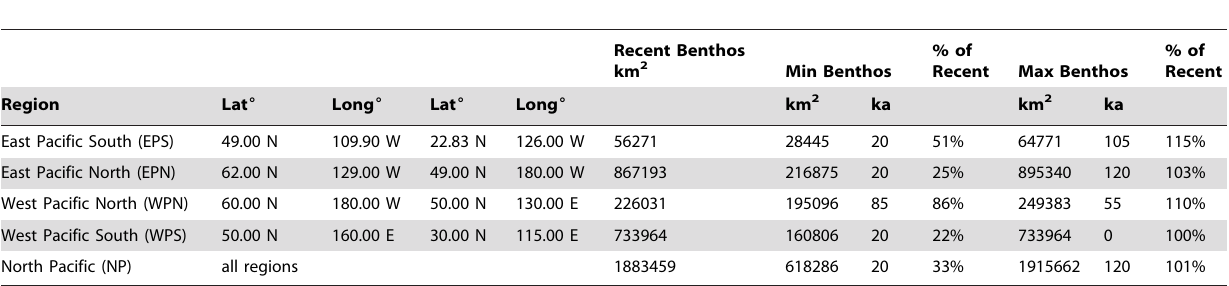
Table 1. Regional definitions and current, minimum, and maximum benthos area available within 75 m of the surface during the last glacial cycle (120 ka), including the age and percent of current benthos of past minimum and maximum events.